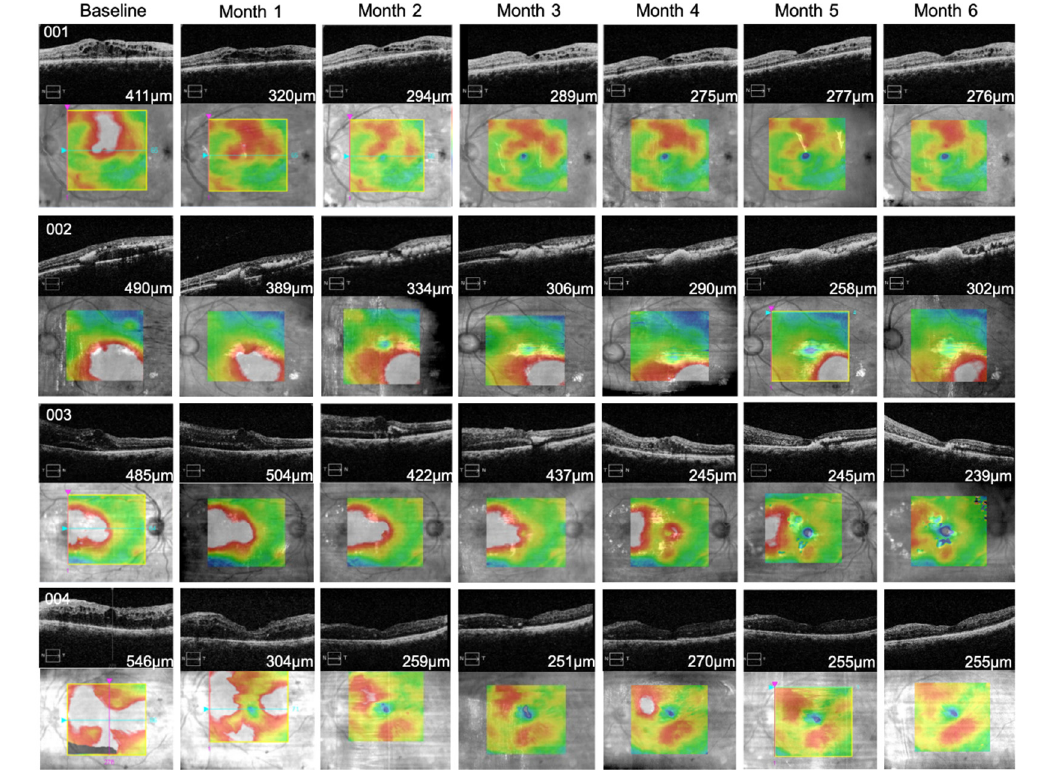
Figure 5. Optical coherence tomography images from patients with diabetic macular edema treated with triamcinolone acetonide-loaded liposomes formulation. A significant reduction in CFT was revealed through OCT analysis in patients receiving TALF. The CFT reduction was maintained through the follow-up in almost all cases. CFT; central foveal thickness, OCT; optical coherence tomography, TALF; triamcinolone acetonide-loaded liposomes formulation.